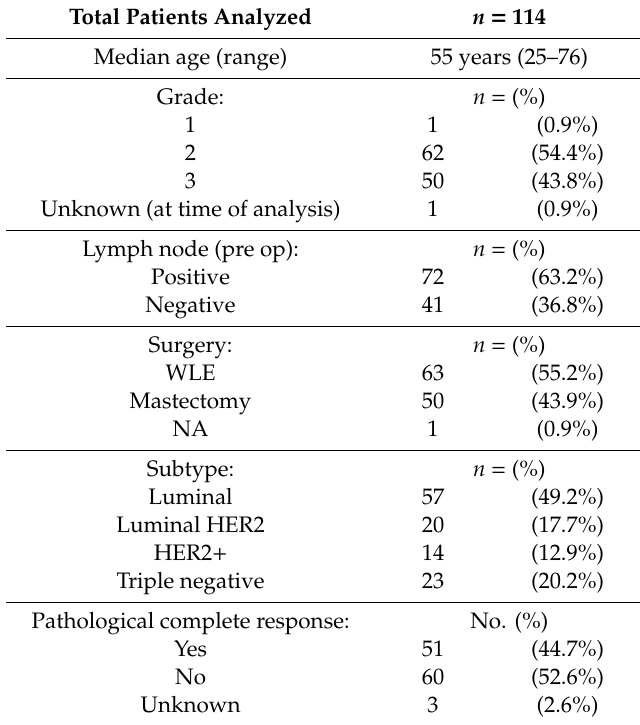
Table 2. Neoadjuvant chemotherapy patient cohort: Clinicopathological details. Total Patients